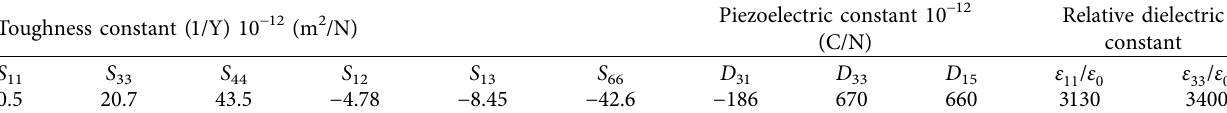
Table 3: The properties of PZT-4.